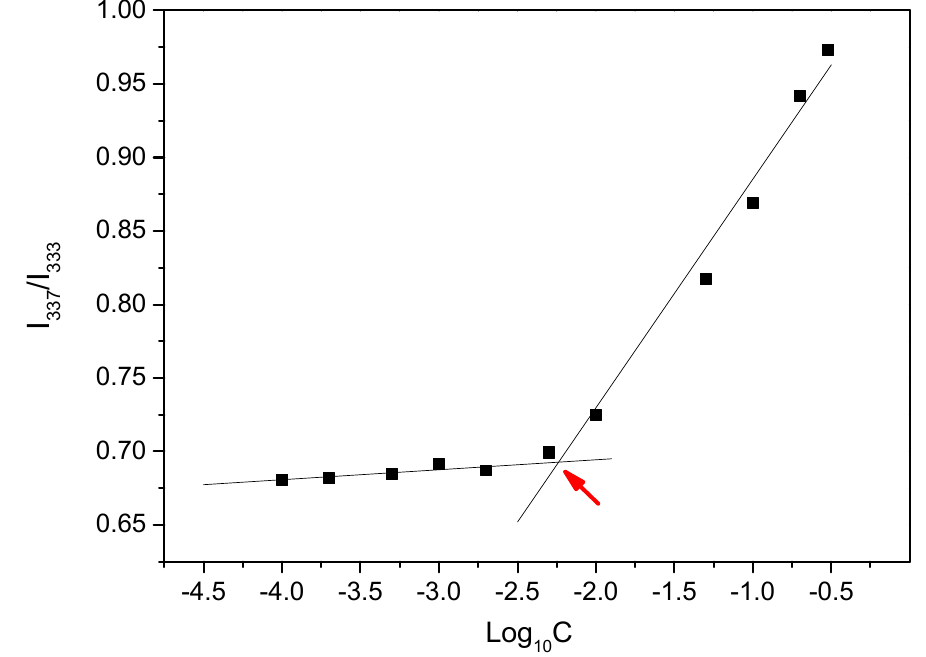
Figure 6. Plots of the intensity ratio I 337 /I 333 of pyrene excitation spectra versus logarithm of concentration for PSAMA 12 - b -PNIPAM 121.